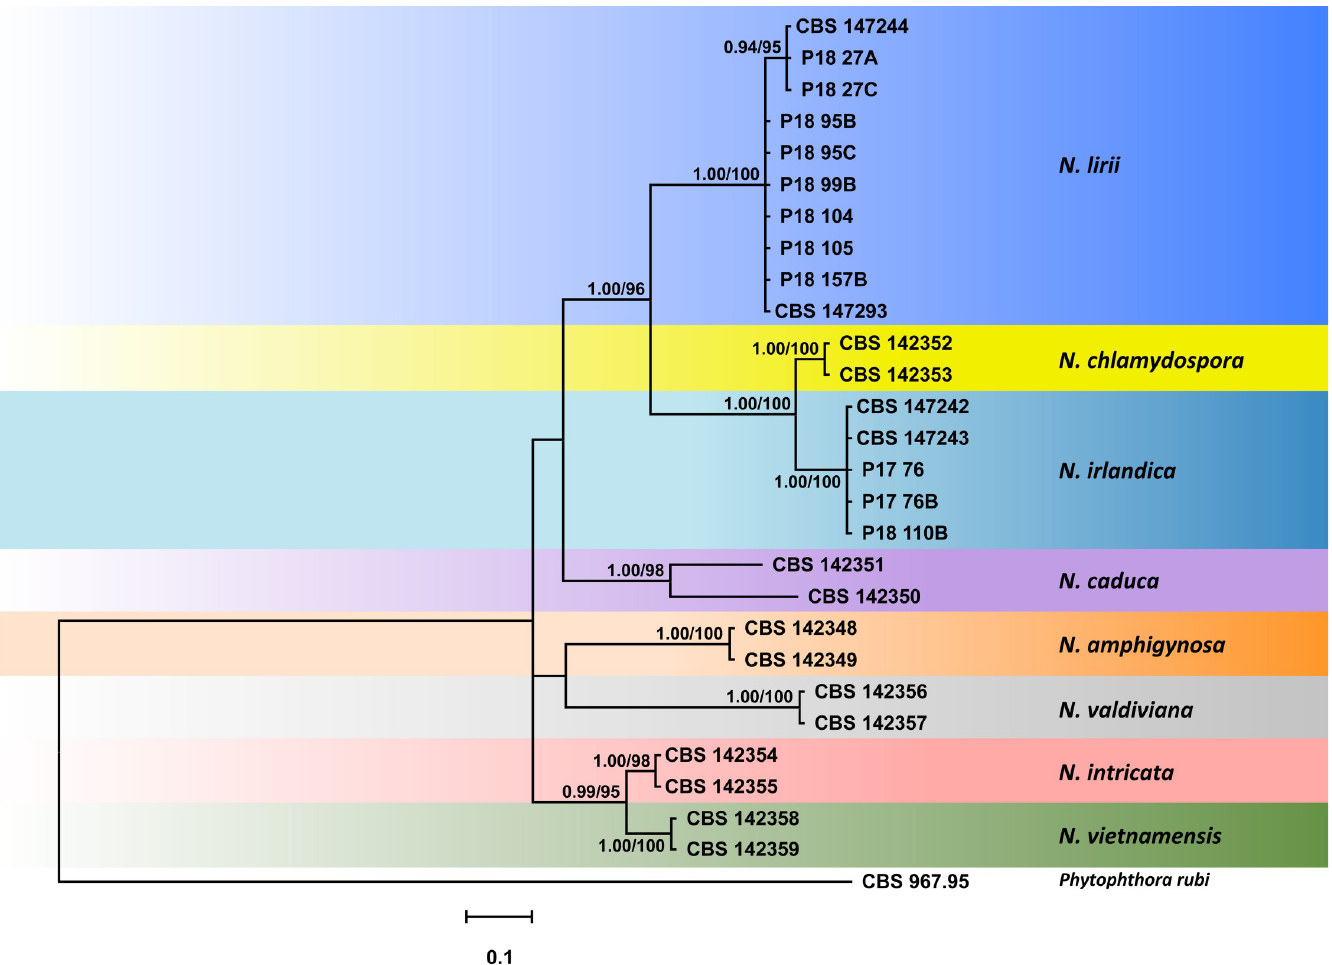
Fig 3. Fifty percent majority rule consensus phylogram derived from Bayesian phylogenetic analysis of mitochondrial 3-loci ( cox1 , nadh1 , rps10 ) dataset of Nothophytophthora irlandica and N . lirii sp. nov. and six known Nothophytophthora species. Bayesian posterior probabilities (left) and Maximum Likelihood bootstrap values (right; in %) are indicated, but not shown below 0.7 and 60%, respectively. Phytophthora rubi was used as outgroup taxon. Scale bar indicates 0.1 expected changes per site per